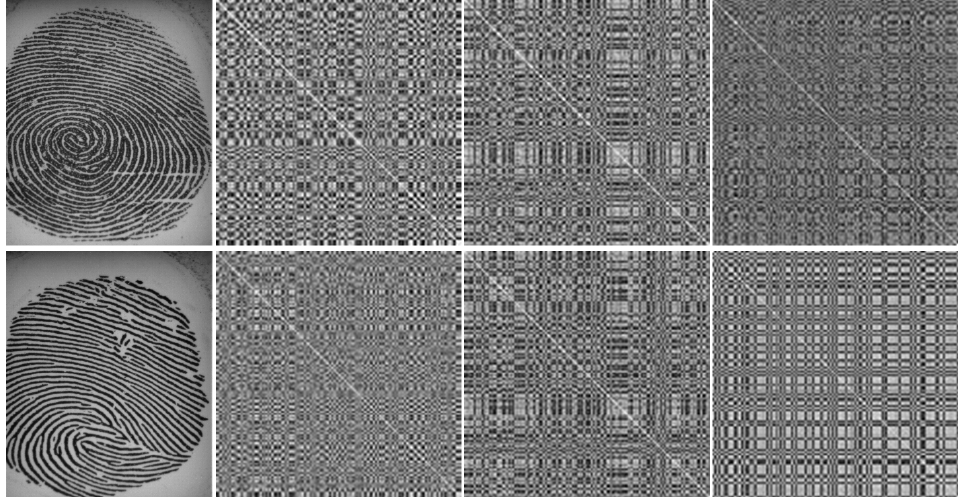
Figure 11. Visualization of Gram matrices (the first row is a live fingerprint, and the second second row is a fake